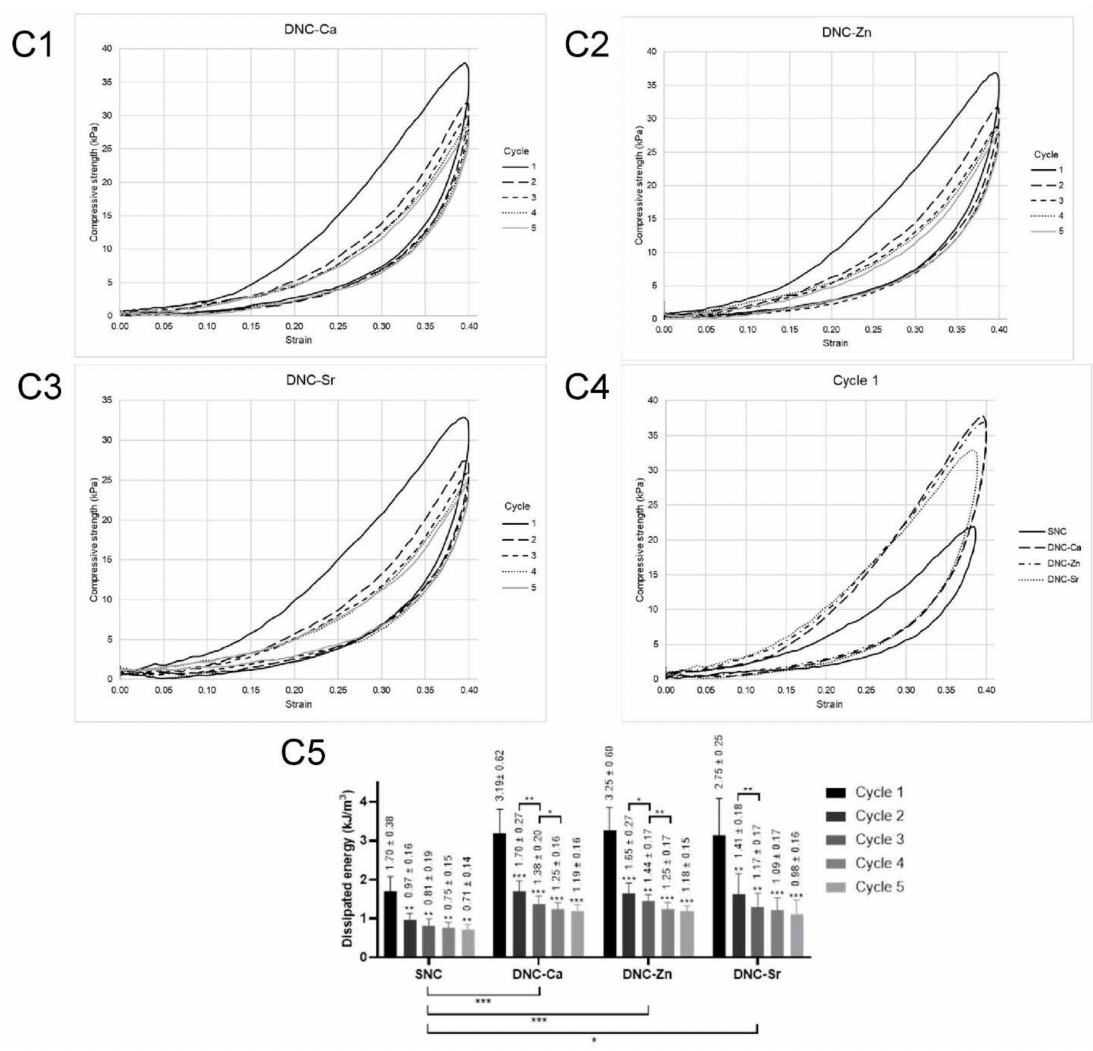
Figure 2. Dual network composites chelated with Ca 2+ (DNC-Ca), Zn 2+ (DNC-Zn) and Sr 2+ (DNC-Sr) under static and dynamic compression compared with the single network composite (SNC): ( A1–4 ) representative image, stress–strain curves, compressive strength and modulus in the dry state and ( B1–4 ) hydrated state (at 10% strain); ( C1 ) representative image, stress–strain curves up to 40% strain for five compressive cycles in the hydrated state of DNC-Ca, ( C2 ) DNC-Zn, ( C3 ) DNC-Sr, ( C4 ) their comparison at the first cycle, and ( C5 ) the dissipated energy at each cycle. Data are displayed as mean ± SD, bars represent means and error bars represent SD’s ( n = 6). Statistical significance was verified with one-Way ANOVA and post hoc Tukey’s analysis (* p < 0.05, ** p ≤ 0.01 and *** p ≤